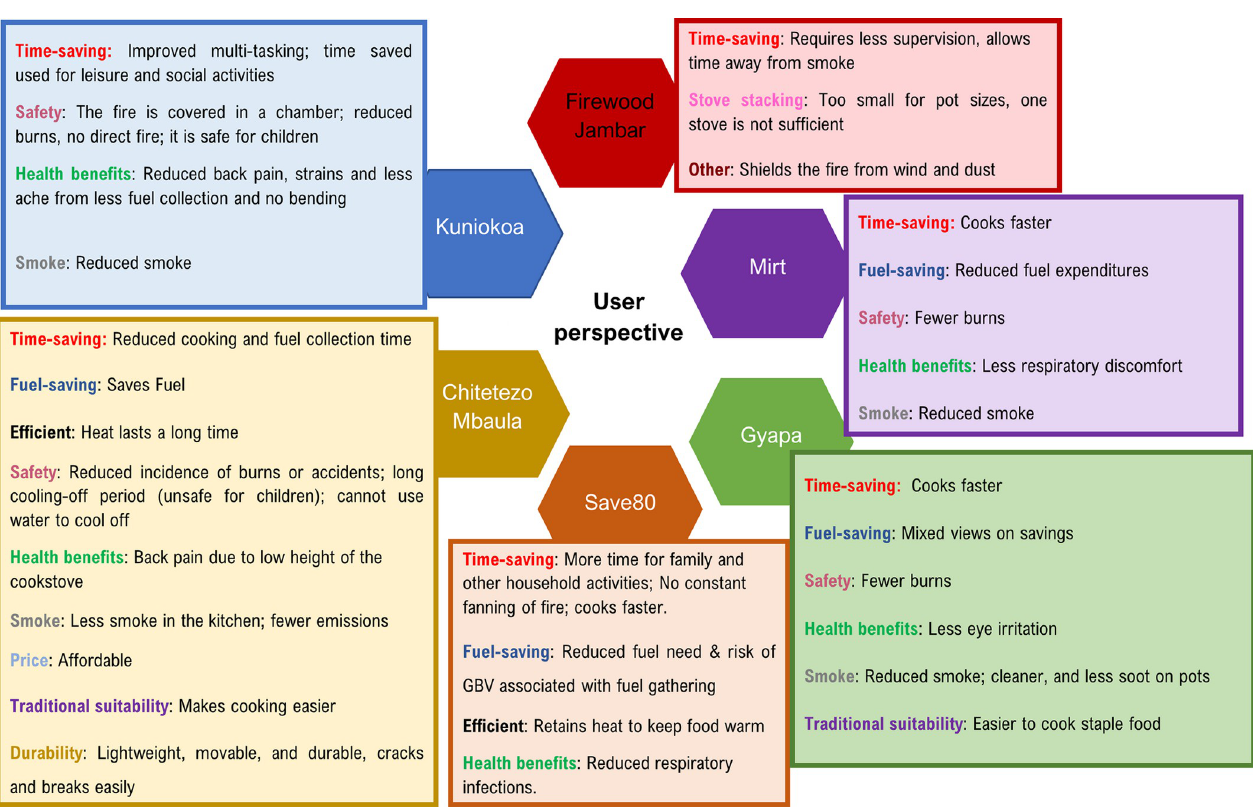
Fig 7. Thematic presentation of user perspectives of available, affordable, and efficient improved cookstove.